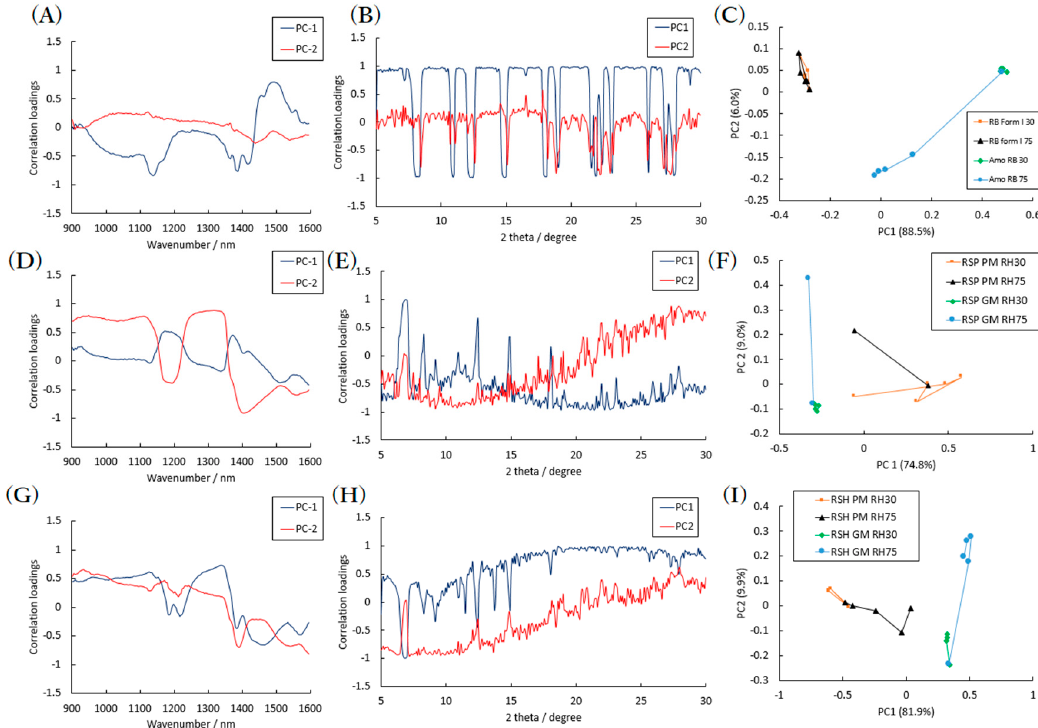
Figure 12. Constructed principal component analysis models based on near-infrared (NIR)-PXRD multi-dataset. NIR ( A ) and PXRD ( B ) loadings and scores ( C ) based on amorphous RB and RB form I dataset. NIR ( D ) and PXRD ( E ) loadings and scores ( F ) based on RB, SDS and PVP samples. NIR ( G ) and PXRD ( H ) loadings and scores ( I ) based on RB, SDS and HPC-SSL samples. RB; rebamipide. SDS; sodium dodecyl sulfate. HPC-SSL; SSL grade hydroxypropyl cellulose. PVP; polyvinylpyrrolidone. PXRD; powder X-ray di ff